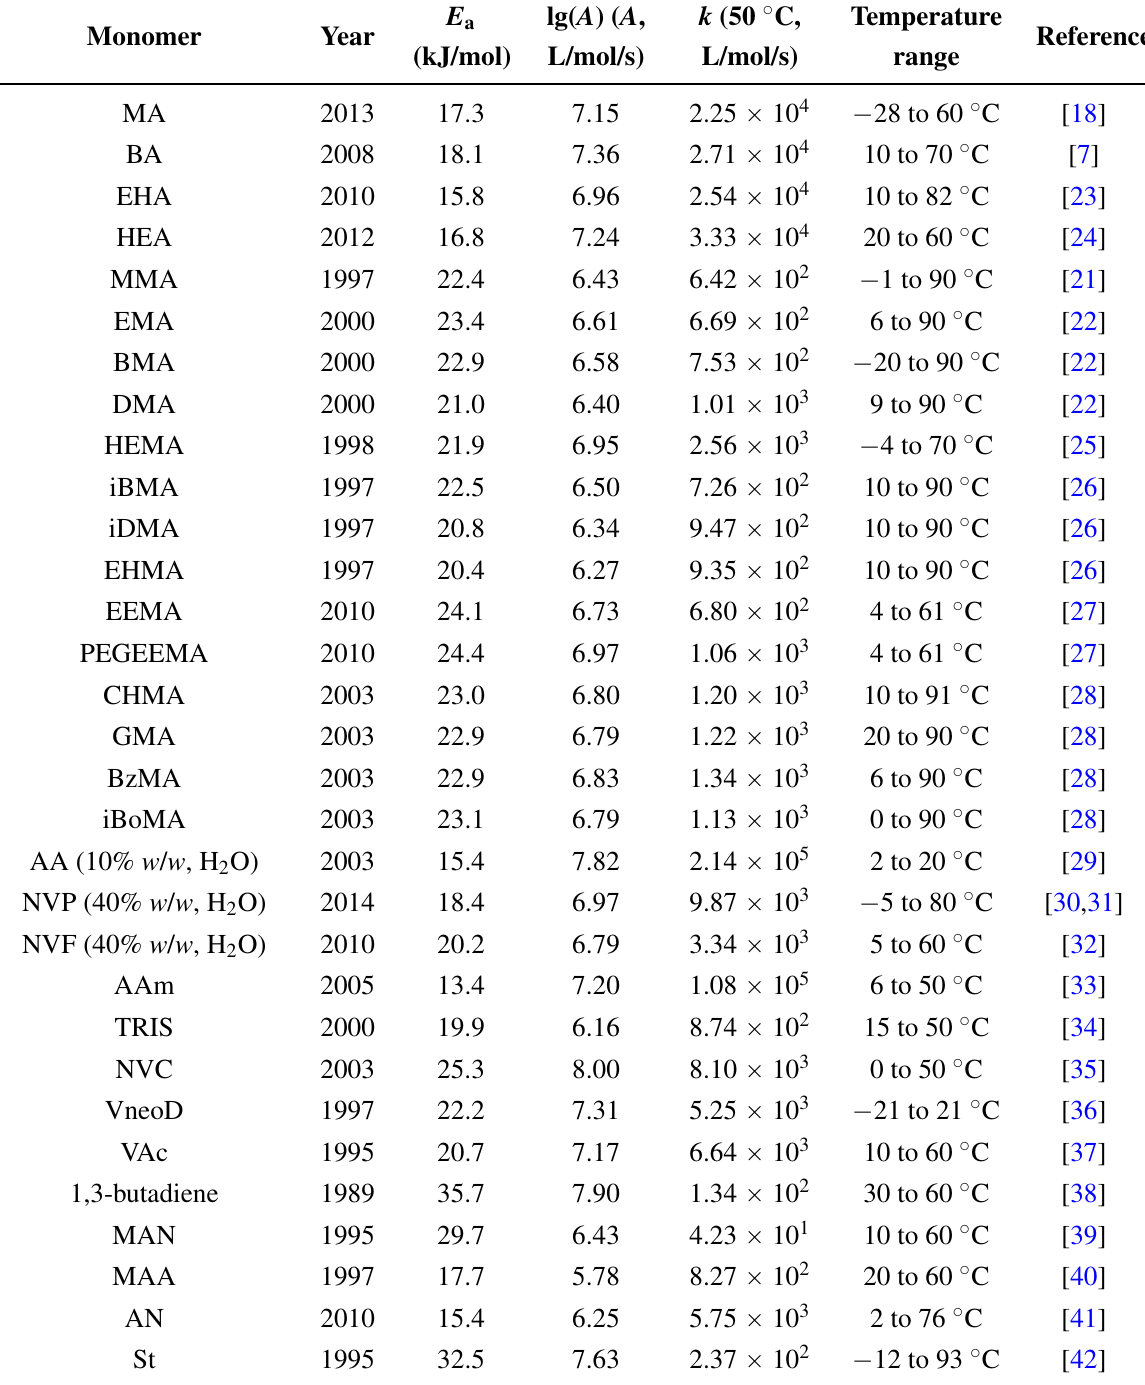
Table 1. Propagation rate coefficients, k , and Arrhenius parameters (activation energy, E , and pre-exponential factor, A ) of the free radical polymerization of various monomers a estimated through pulsed laser polymerization (PLP)